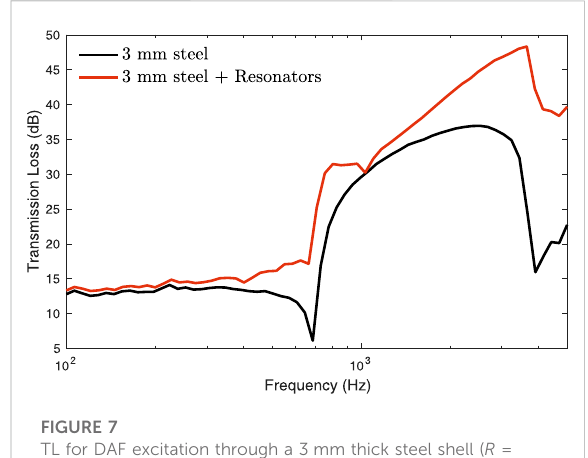
FIGURE 7 TL for DAF excitation through a 3 mm thick steel shell ( R = 1.2 m, δ = 90 ° ) covered by a layer of Helmholtz